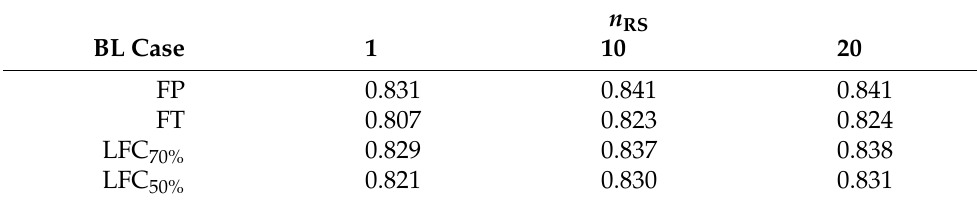
Table 1. η s , tt for varying numbers of radial